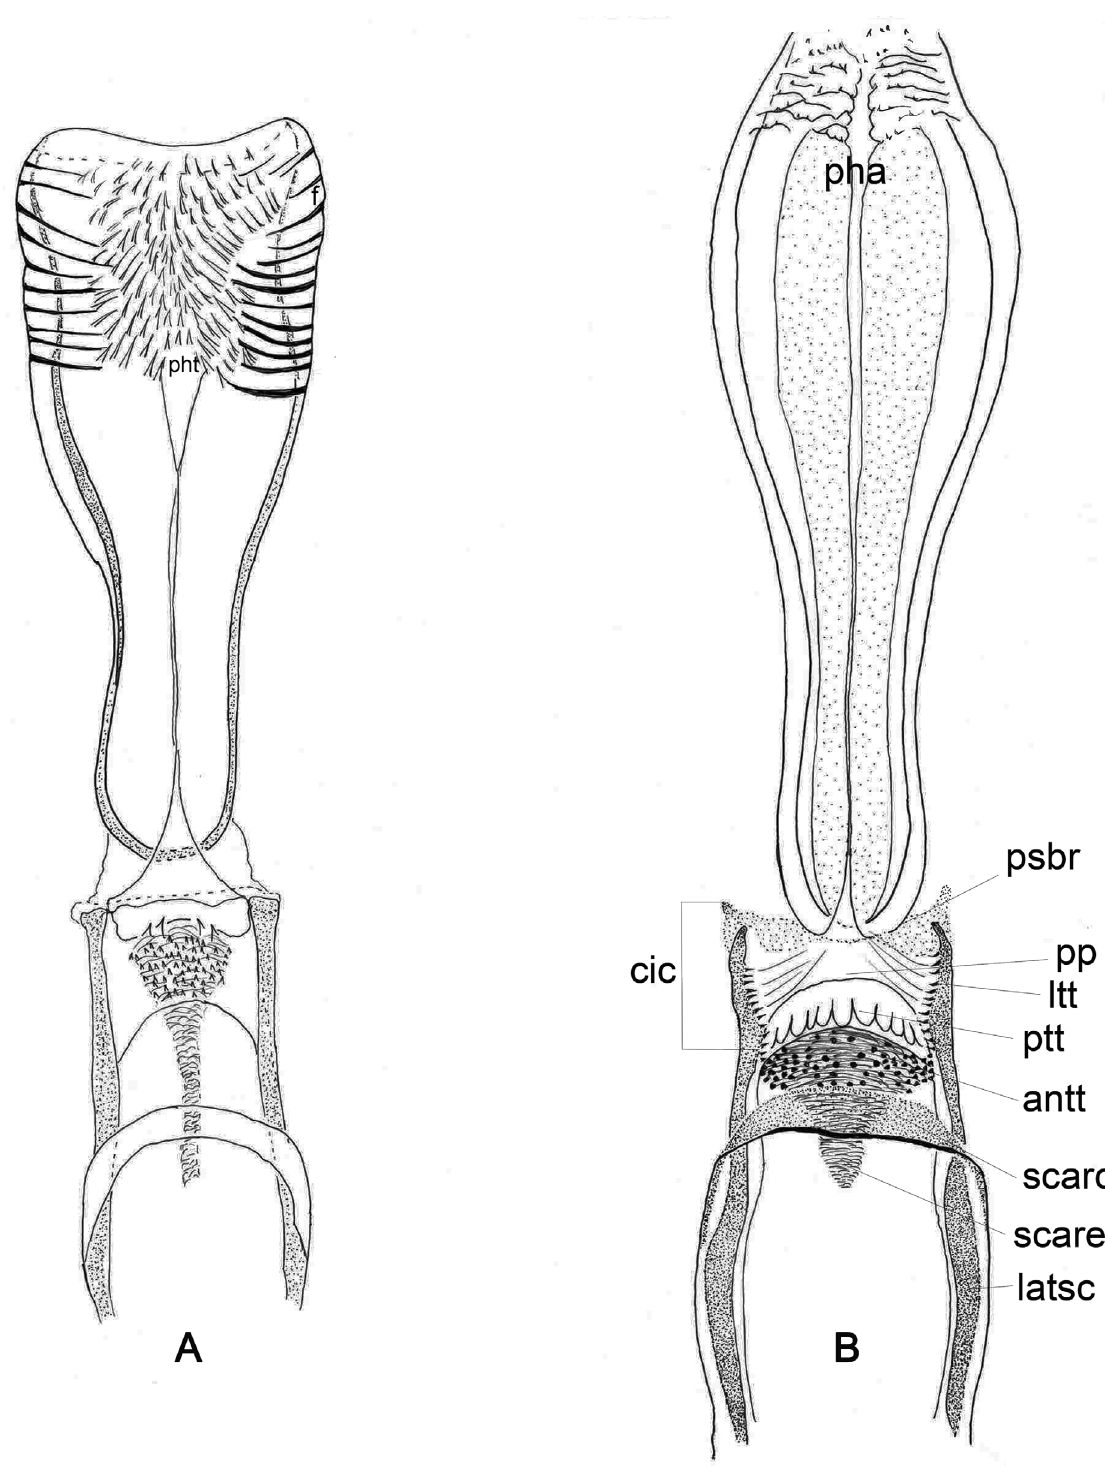
Figure 7. Cibarium and pharynx of phlebotomine females. (A) Micropygomyia atroclavata ; (B) Bichromomyia flaviscutellata . antt – Anterior teeth; cic – cibarial chamber; f – fold; ltt – lateral teeth; pha – pharynx; pht – pharyngeal teeth; psbr – posterior bridge; ptt – posterior teeth; pp – posterior protuberance; latsc – lateral sclerite; scarc – sclerotized arch; scare – sclerotized